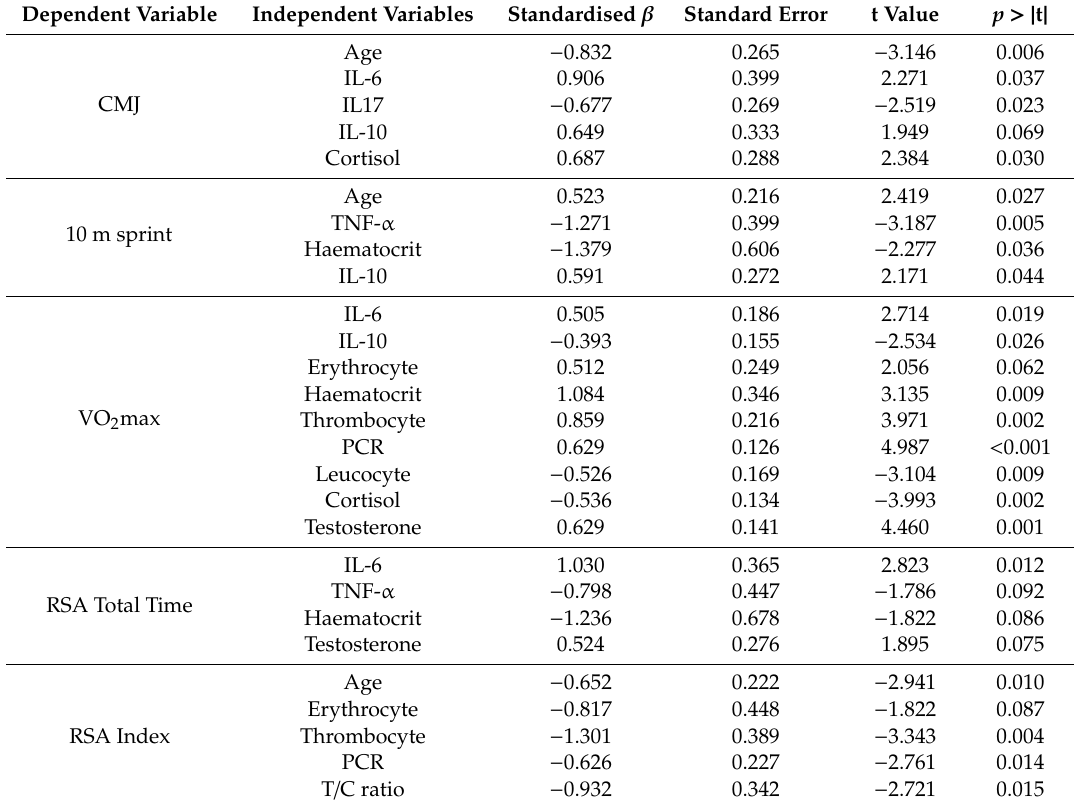
Table 2. Multiple linear regression with backward stepwise